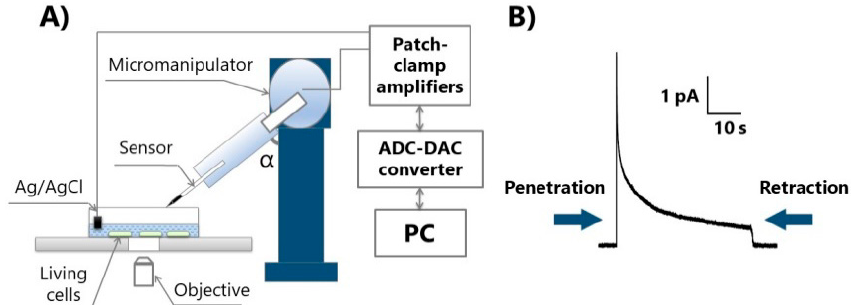
Figure 4. In vitro ROS measurements. ( A ) Scheme showing the setup for intracellular measurements. ( B ) ROS intracellular measurements. Recording a difference of the current value between the solution and a single cell.